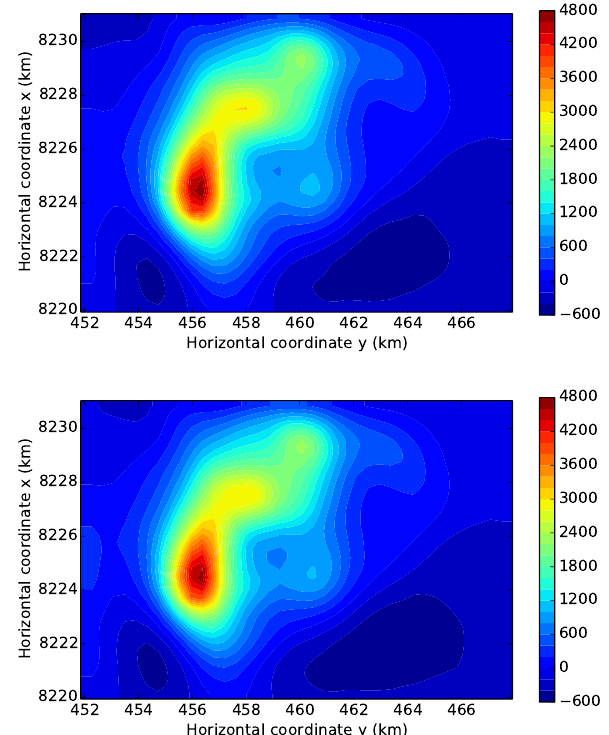
Figure 18. Application to field data on the Goiás alkaline province (GAP), Brazil. Observed total-field anomaly (Fig. 17) reduced to the pole. The upper and lower panels show the RTP anomalies computed by using, respectively, the estimated magnetization direc- tion obtained with the least-squares (inclination ˆ I = − 69 . 25595 ◦ ± 0 . 00013 ◦ and declination ˆ D = − 16 . 22821 ◦ ± 0 . 00050 ◦ ) and ro- bust (inclination e I = − 71 . 41751 ◦ ± 0 . 00182 ◦ and declination e D = − 23 . 39541 ◦ ± 0 . 01049 ◦ )